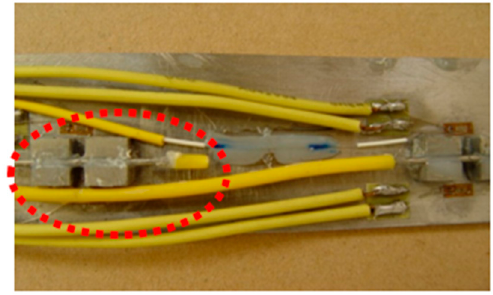
Figure 8. The specimen of hard aluminum.